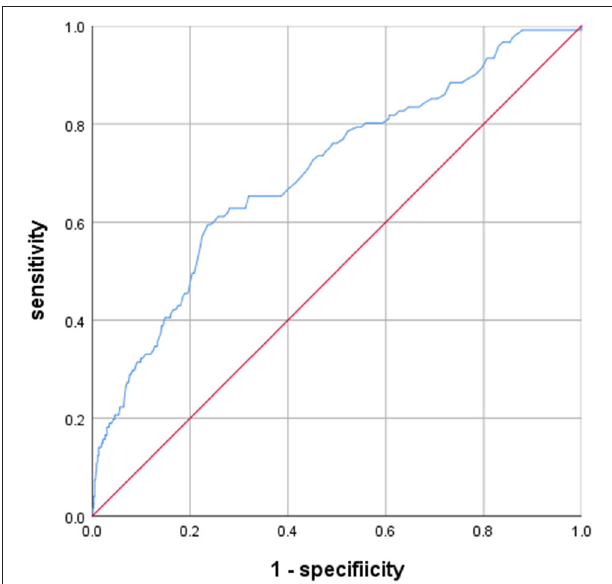
FIGURE 2 | Predictive values of LDH for 3-month modified Rankin Scale (mRS) > 2 area under curve 0.702 (95% confidence interval [CI], 0.650–0.754; p <